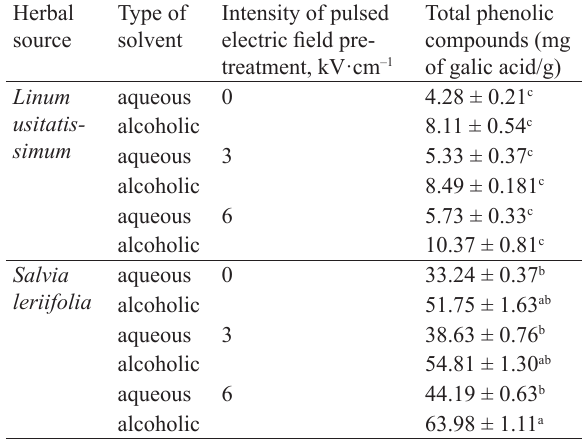
Figure 1 Independent effects of herbal source (a), pre- treatment (b), and solvent type (c) on total phenolic compounds ( P < 0.05)